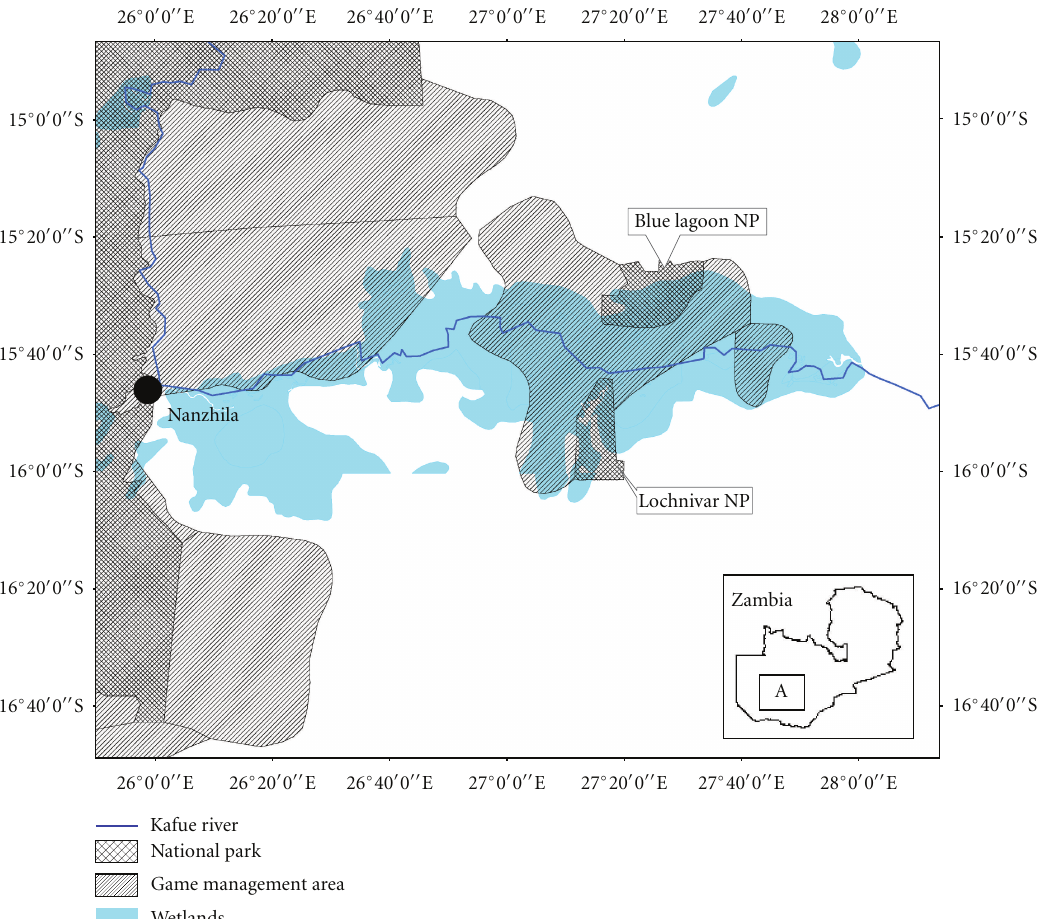
Figure 1: Map of the Kafue basin ecosystem with one big black dot (Nanzhila) showing the study site were the bu ff aloes were captured and quarantined for the BTB intradermal skin test. The insert shows the map of Zambia with A showing the location of the Kafue basin